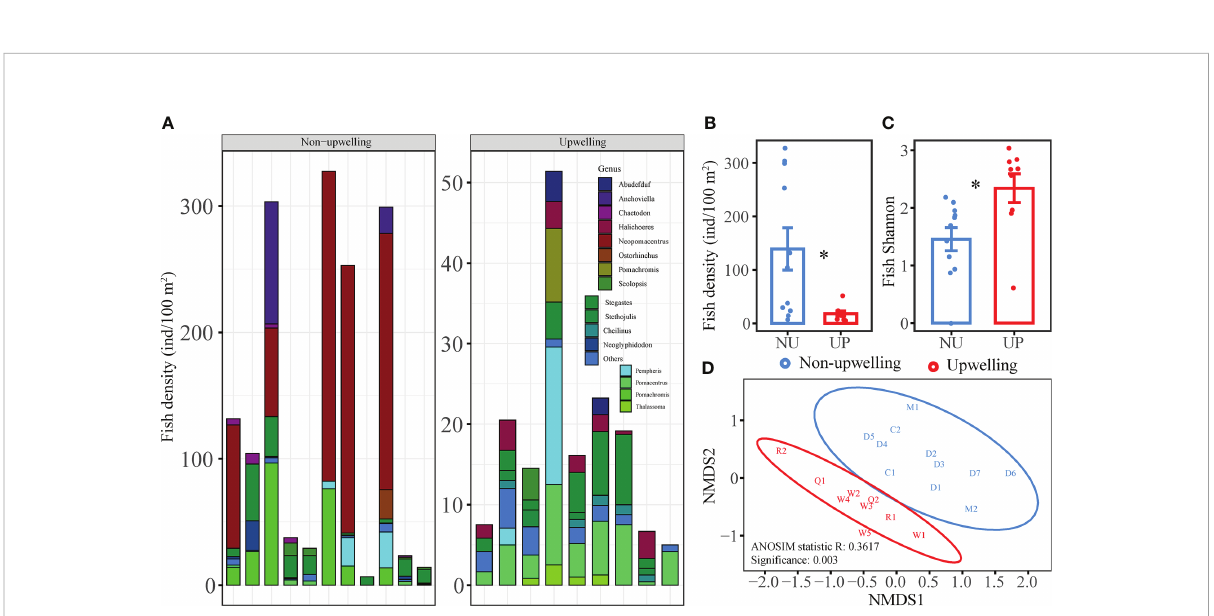
FIGURE 5 Comparison of fi sh composition, fi sh density, fi sh diversity, and fi sh community of the QDU and non-upwelling zones: (A) Density of coral reef fi sh at genus level; (B) Total fi sh density; (C) Fish diversity; (D) NMDS of Bray – Curtis distances of the fi sh community. The symbol "*"denote p value less than